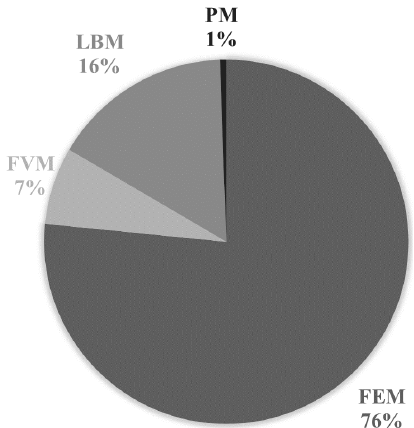
Figure 6. Distribution of papers in overall discretisation method: FEM = finite element methods; FVM = finite volume methods; LBM = lattice Boltzmann methods; PM = particle-based